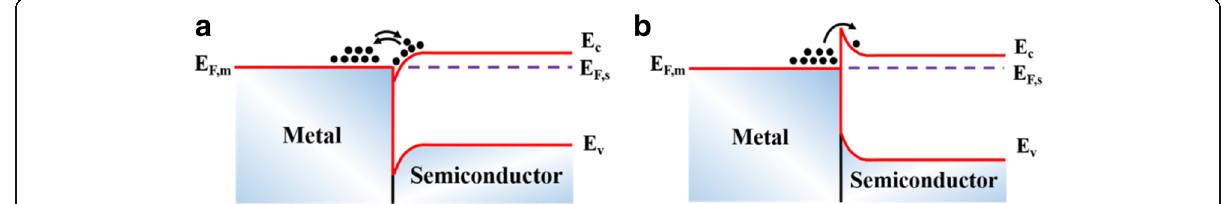
Fig. 1 Schematic illustrations of a Ohmic contacts and b Schottky contacts. E C , E V , E F , m , and E F , s are the energy levels of the conduction band edge, valence band edge, Fermi energy of metal and semiconductor,